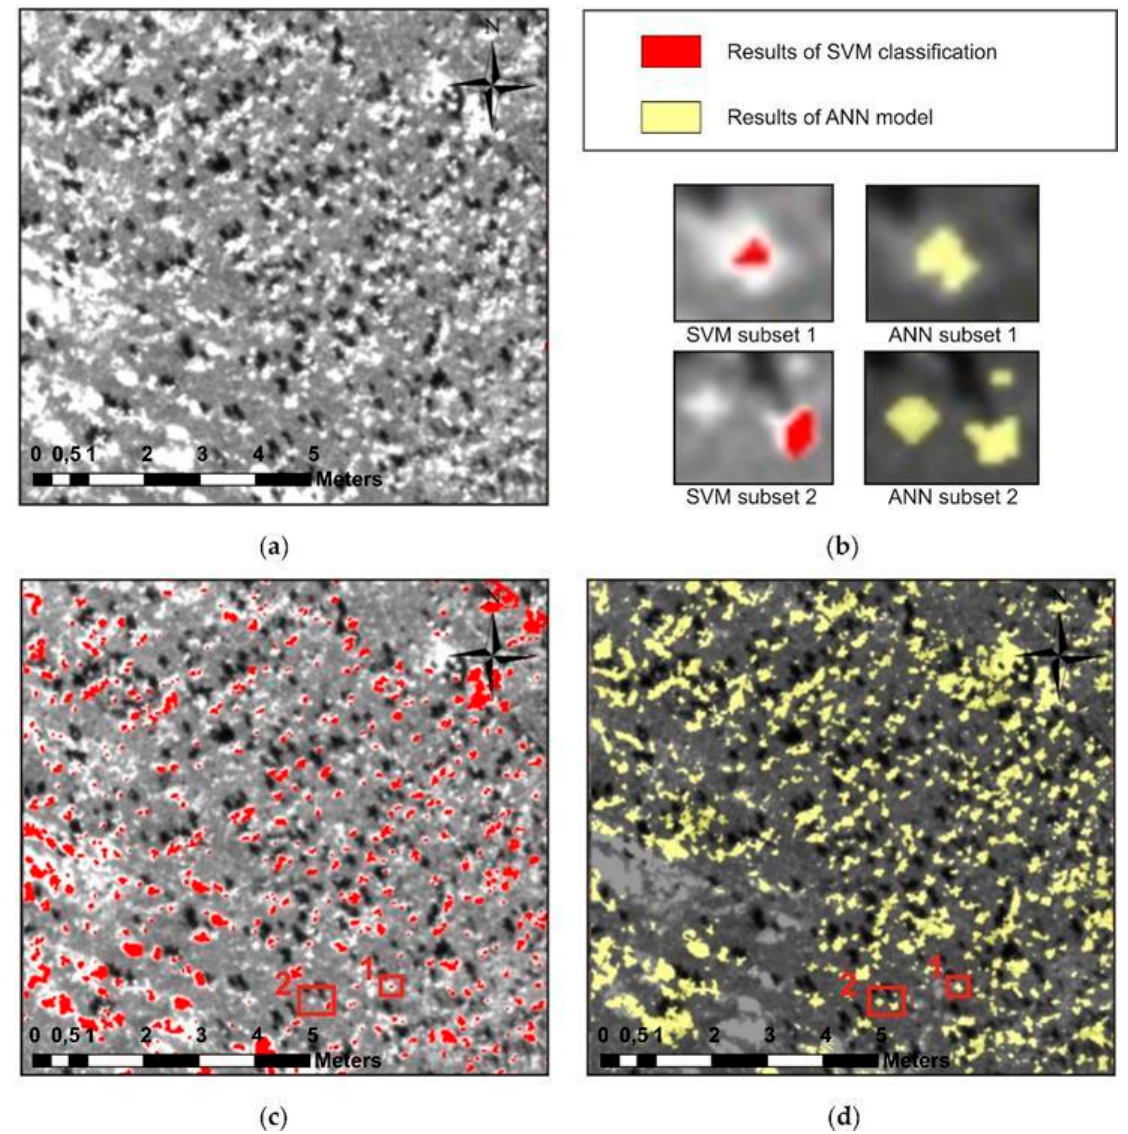
Figure 7. Larger subset of the study area with heavy infection by common milkweed plants on a single band of the HS orthomosaic ( a ). The results of SVM classification ( c ) are highlighted with red, and the results of ANN model ( d ) are highlighted with yellow shows the differences between the results of the classifications on an example of a single plant ( b ).